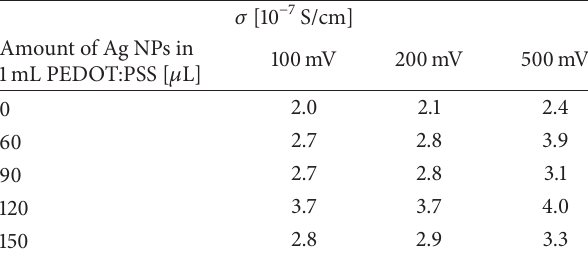
Table 2: Conductivity values of PEDOT:PSS:Ag NPs